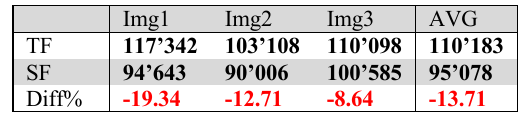
Table 3 . The features detection with and without segmentation.